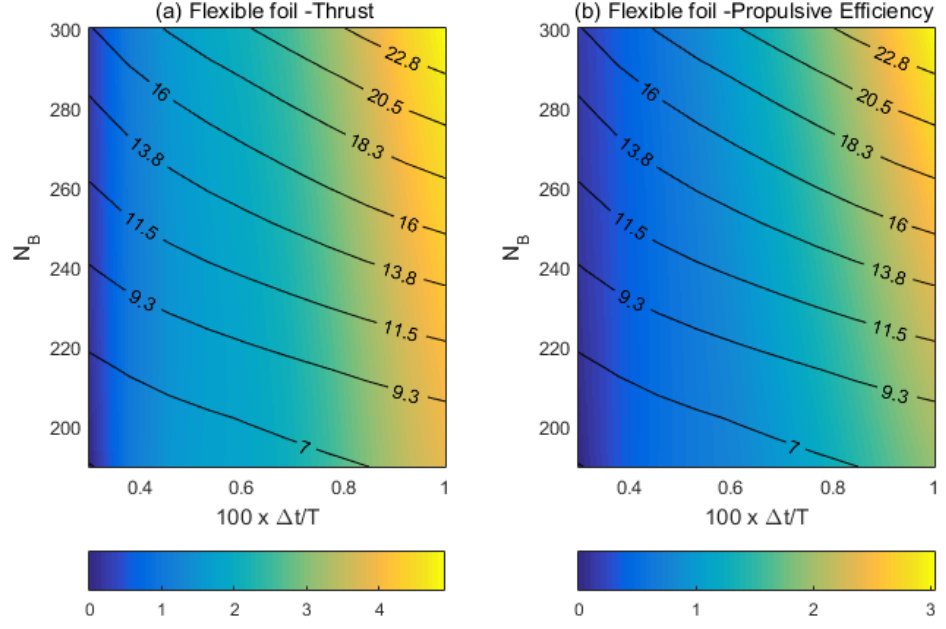
Figure 8. Relative error (%) of ( a ) the thrust e ffi ciency coe ffi cient C T (left) and ( b ) the propulsive e ffi ciency η F (right) with respect to the value of the finest discretization simulated with BEM–NR. The error is denoted by the color-bar, and the contours display the iso- λ values. For the following kinematic parameters h o / c = 0.75, α ef f = 22 ◦ , Str = 0.3, x R = x LE , ψ = − 90 ◦